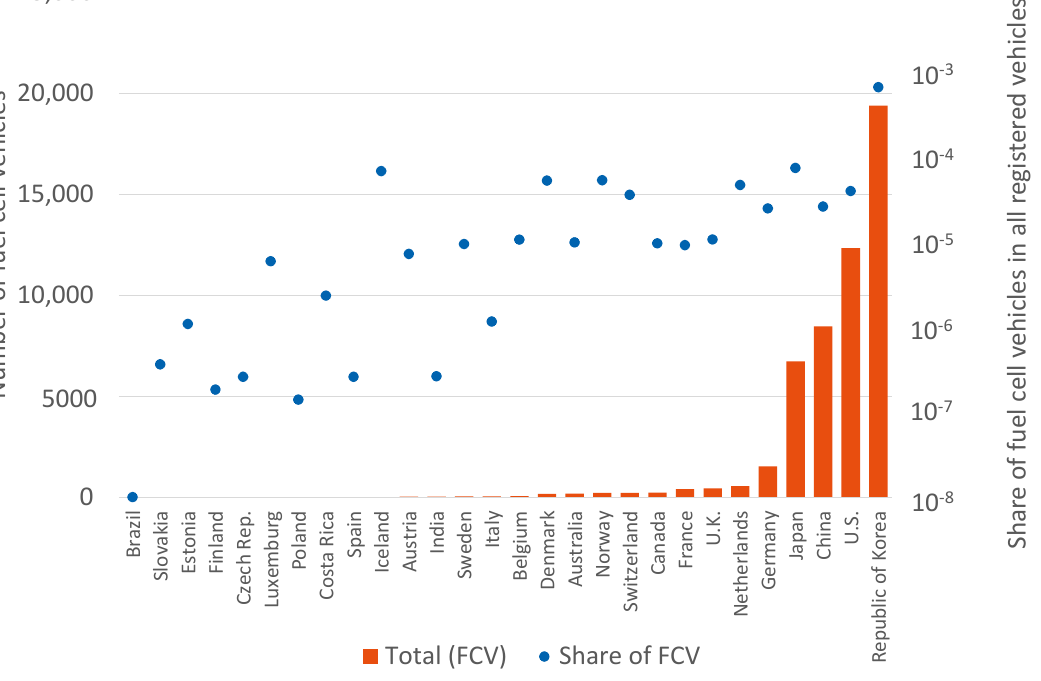
Figure 15. Number of FCVs at the end of 2021 from this study (left) vs. the share of FCVs among all registered vehicles based on the WHO database (right) [139].